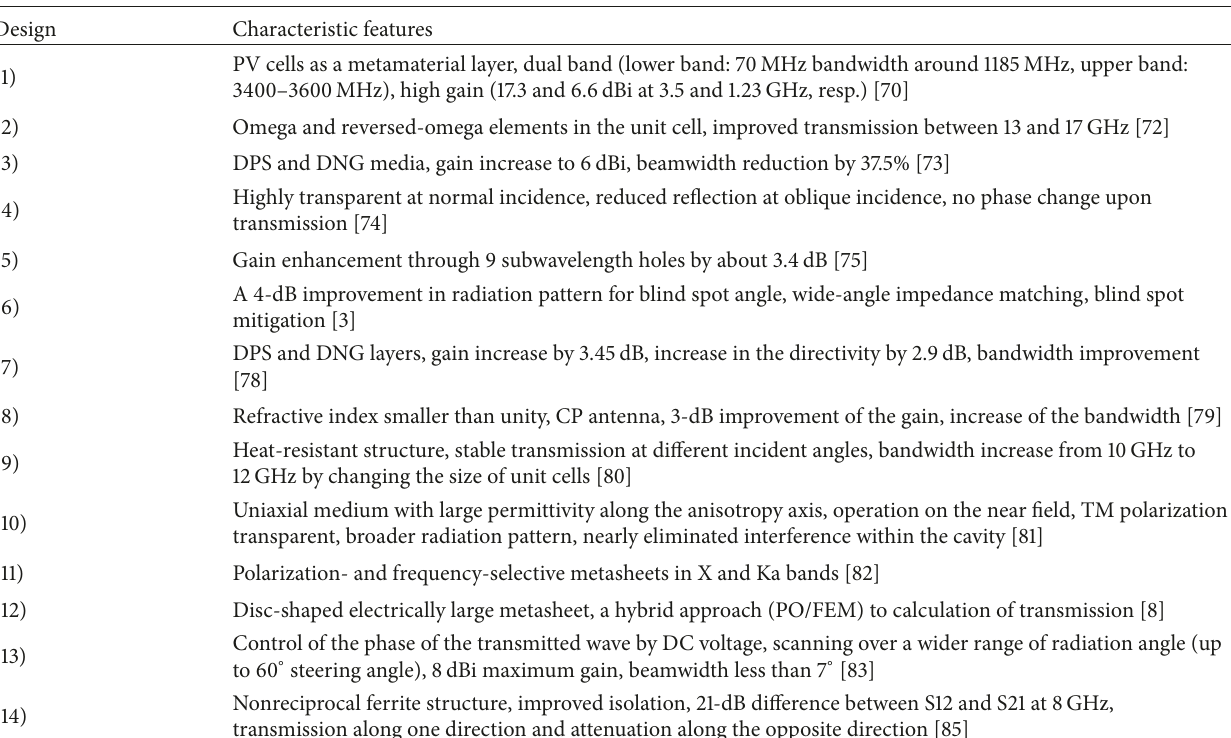
Figure 8: The operation of a superlens. Propagating and evanescent fields from the source go through a planar slab of negative-index material to form an image of the source. The image includes details finer than the wavelength, which cannot be realized by positive-index lenses [52]. Table 1: The list of the characteristic features of the metaradome designs described in Section